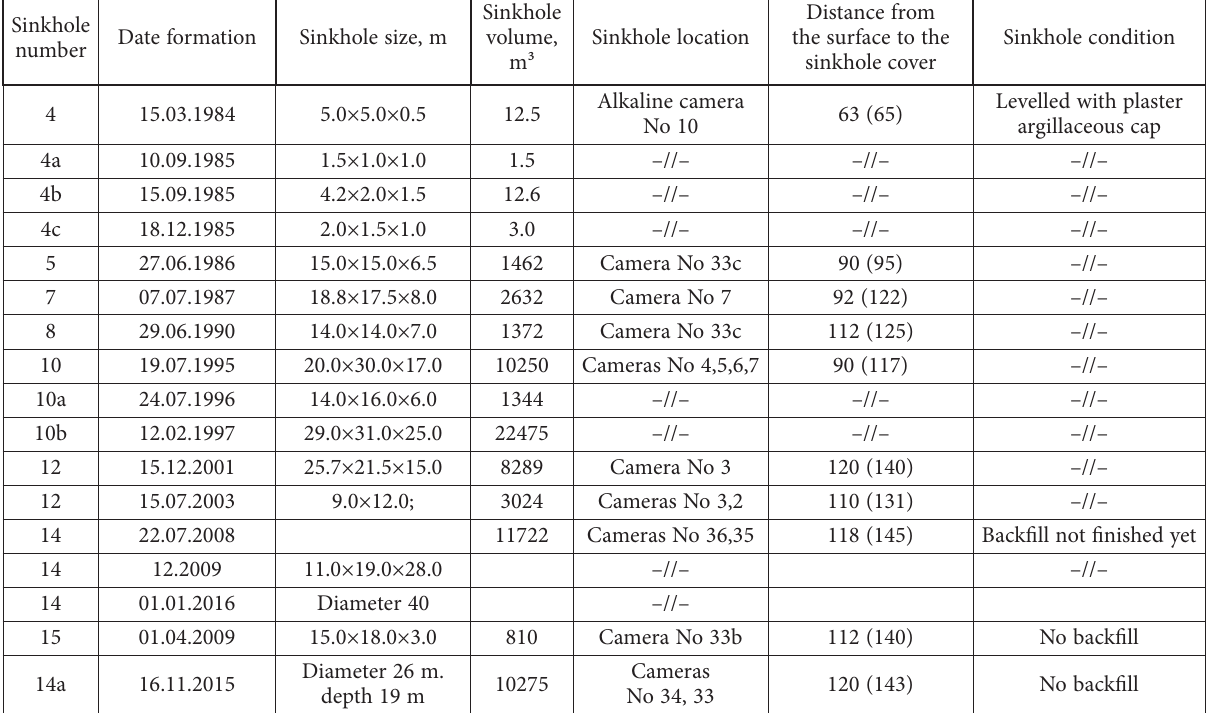
Table 1. Sinkholes’ characteristic which formed at the North kainite ore